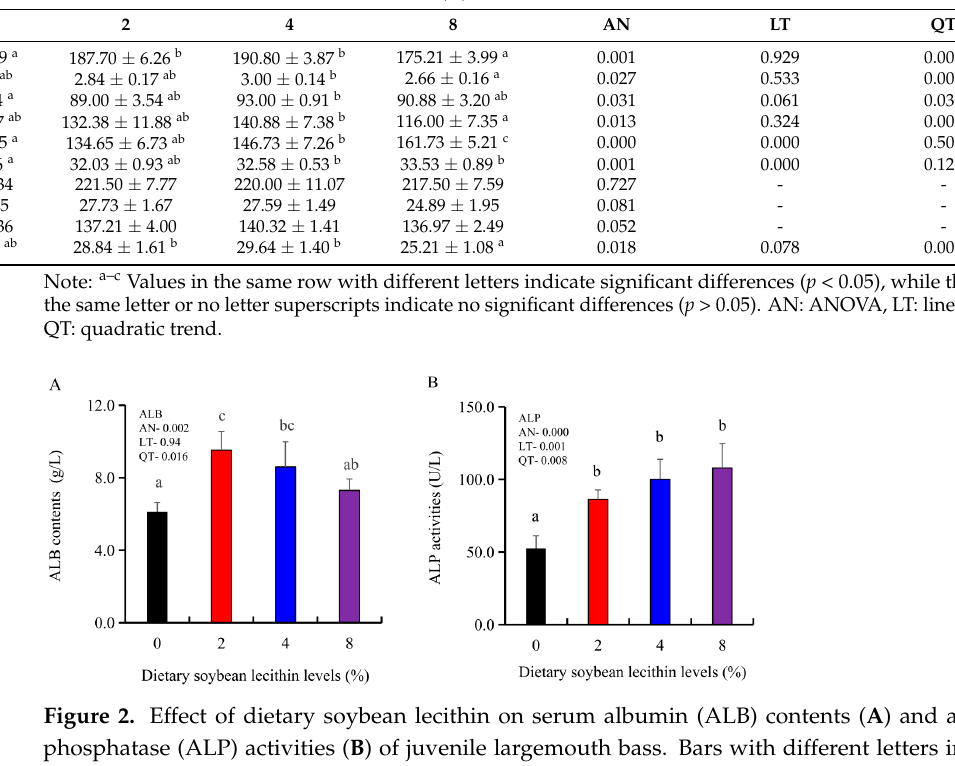
Table 3. Haematological parameters of juvenile largemouth bass fed diet trials. Lecithin (%) in Diets